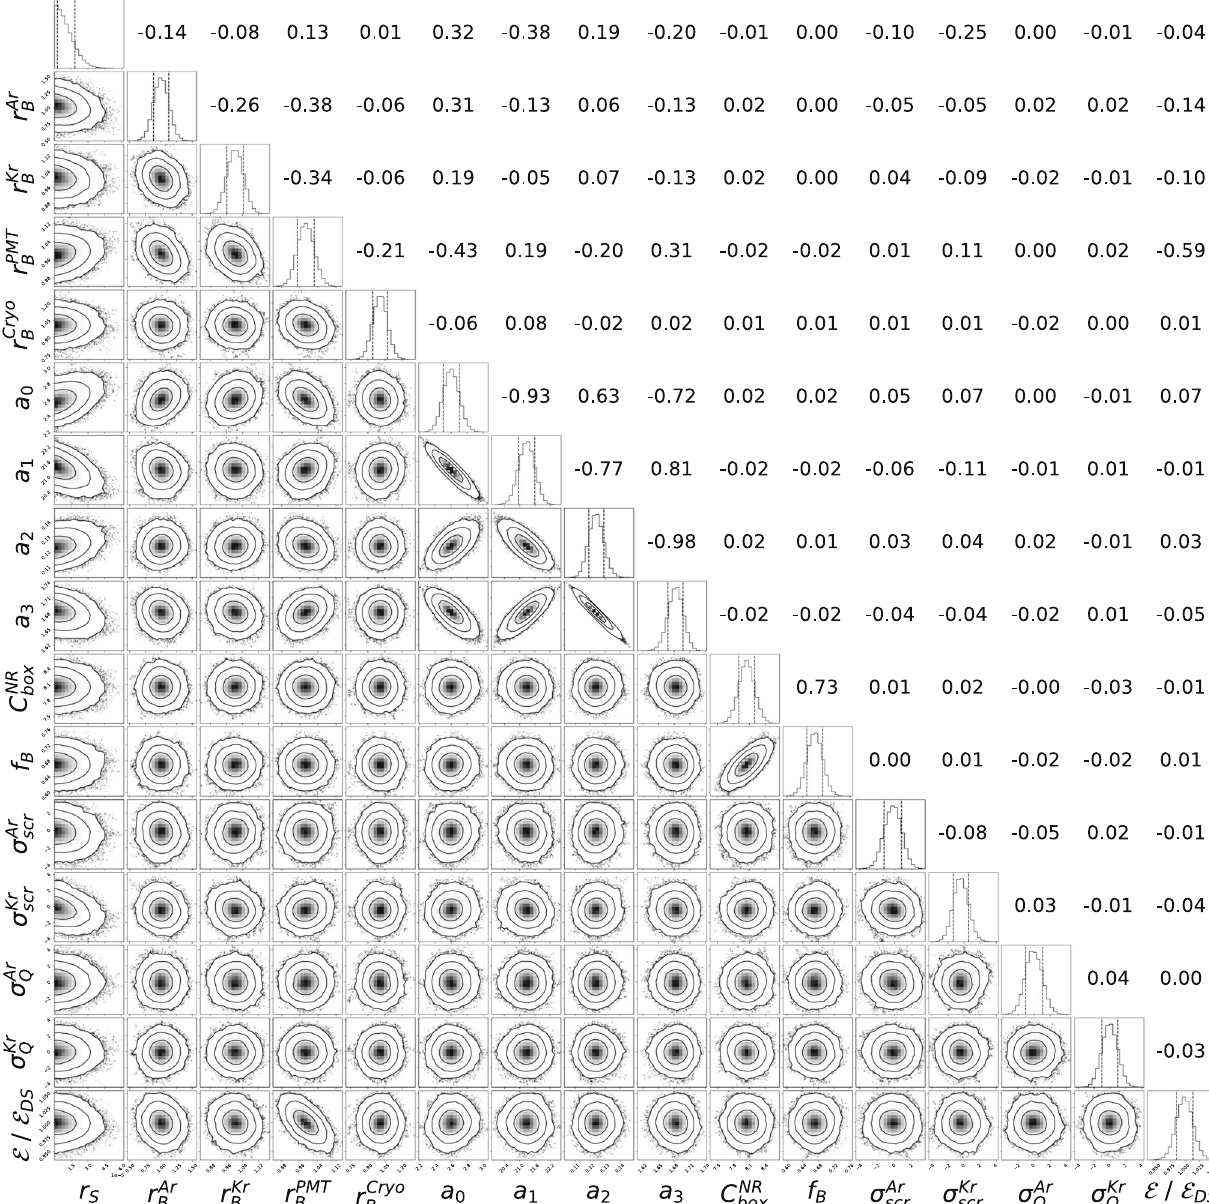
pdf sofeachpairofparametersobtainedbymarginalizingontheothers. The plots show also the credible regions at 68% , 95% , 99 . 7% prob- ability as solid contour lines. The correlation coefficients are given in the upper-right corner of the